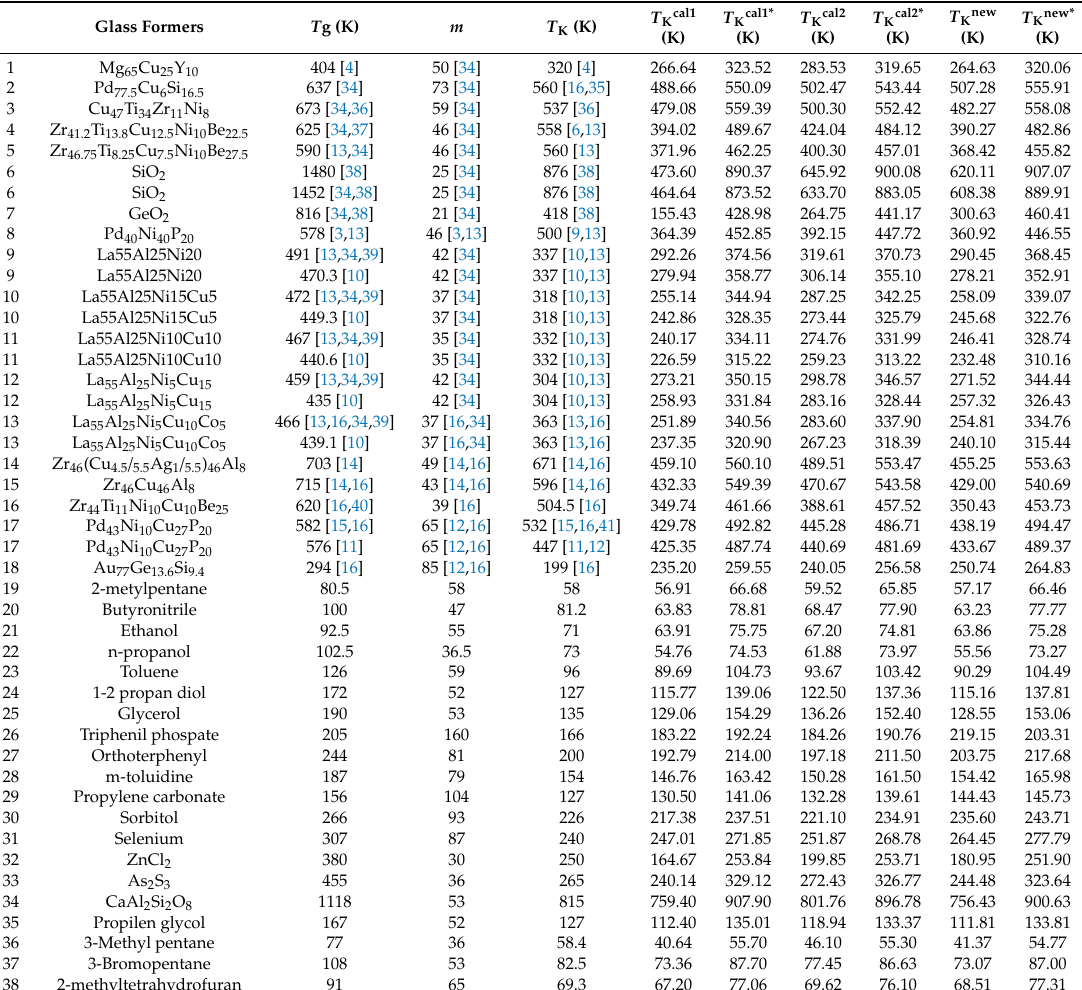
Figure 3. The predicted Kauzmann temperature obtained by Equation (11). ( a ) m min = 17; ( b ) m min = 11.50. Table 1. The values of T g , T K , and m for various glass-forming liquids. The data (numbers 19–38) were taken from Ref.